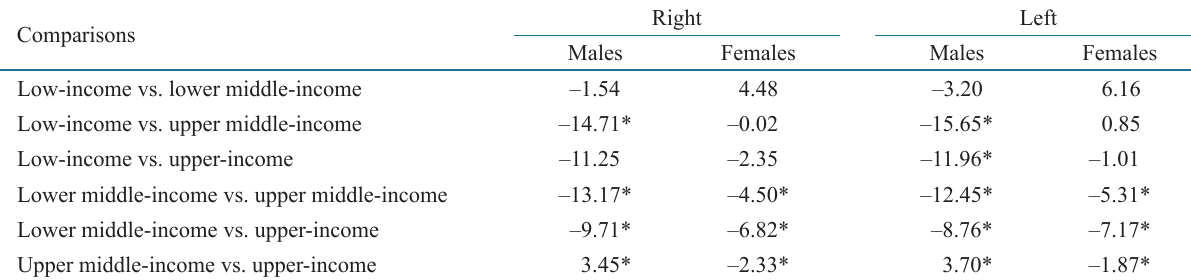
Mean hand grip score difference (kg) from comparison of country economic status